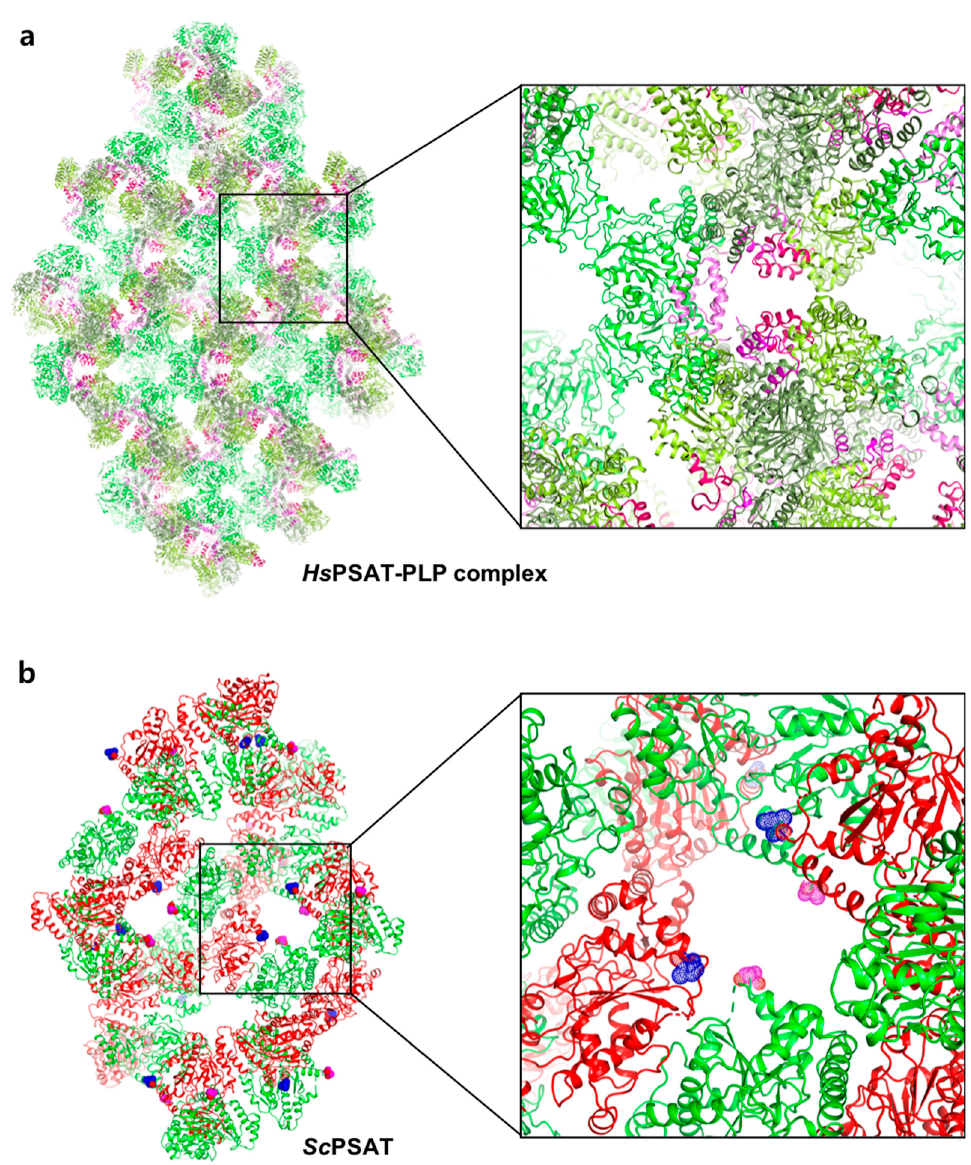
and magenta colors, respectively. Conformational change of β 6– β 7 is indicated by the red arrow. ( c ) Detailed view of the active site by superimposed structures of Sc PSAT (blue) and Hs PSAT (orange). Residues His44 and Arg45 are from a neighboring molecule of Hs PSAT. Lys218, His45, and Arg46 of Sc PSAT (equivalent to His44 and Arg45 of Hs PSAT) could not be modeled due to weak electron density. PLP is colored yellow. ( d ) Overall structures of PSAT from Saccharomyces cerevisiae , Salmonella enterica (PDB code: 3QM2), and Homo sapiens (PDB code: 3E77). The N-terminal 53 residues are colored green. His44 and His45 in the HsPSAT-PLP complex are indicated by red-dotted surface representation.